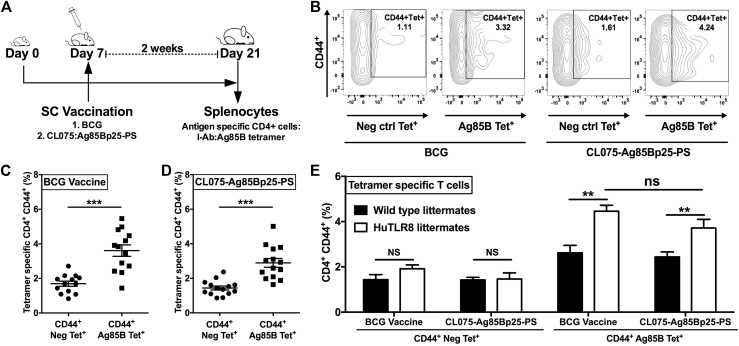
CL075:Ag85Bp25-PS and BCG induce comparable Ag85B-specific CD4+ effector T cells in the spleens of neonatal huTLR8Tg mice. A, Experimental design: 7-day-old huTLR8Tg and matched littermate WT mice were immunized subcutaneously and killed 14 days later before harvesting spleens and staining splenocytes with a control versus Ag85B280–294 MHCII tetramer and for surface marker expression. B, Representative flow cytometric plots showing Tet+ T cells as CD44+ Neg Tet+ or CD44+ Ag85B Tet+ cells gated on live CD4+ splenic lymphocytes of BCG- or CL075-Ag85Bp25-PS–vaccinated mice 2 weeks after immunization. C and D, Similar to BCG, CL075-Ag85Bp25-PS induced a significant increase in CD44+ Ag85B Tet+ cells compared with CD44+ Neg Tet+ cells. Results represent means ± SEMs (n = 14-15), with significance relative to unspecific control tetramer. E, Neonatal humanized TLR8 mice have greater numbers of splenic Ag85B-specific CD4+ T cells versus their WT littermates. The unpaired Mann-Whitney test was applied, and statistical significance was denoted as follows: **P < .01 and ***P < .001. NS, Not significant.